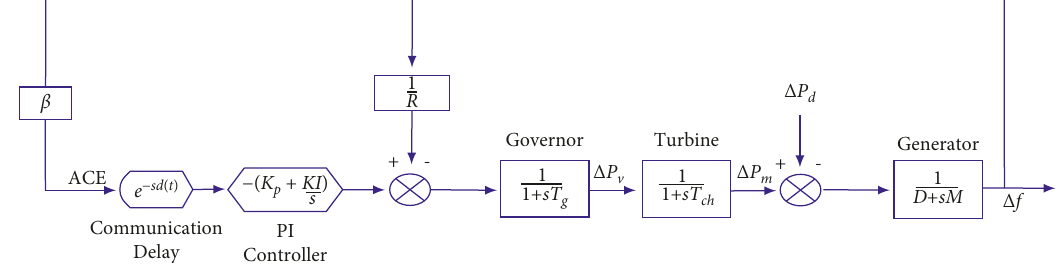
Figure 1: Dynamic model of one-area LFC